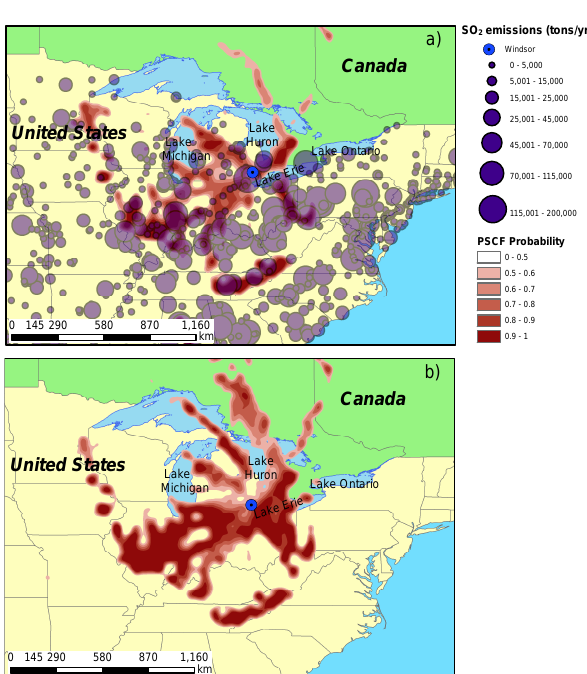
Figure 9. Potential source contribution function (PSCF) plot for the Sulfate-OA (a) and Nitrate-OA (b) factors from the PMF Full MS analysis. Both factors showed regional source influences, with the Sulfate-OA factor showing more prominent, distant influences to the south and southwest. The Nitrate-OA factor showed the most prominent influences to the southwest, over Indiana and Illinois.